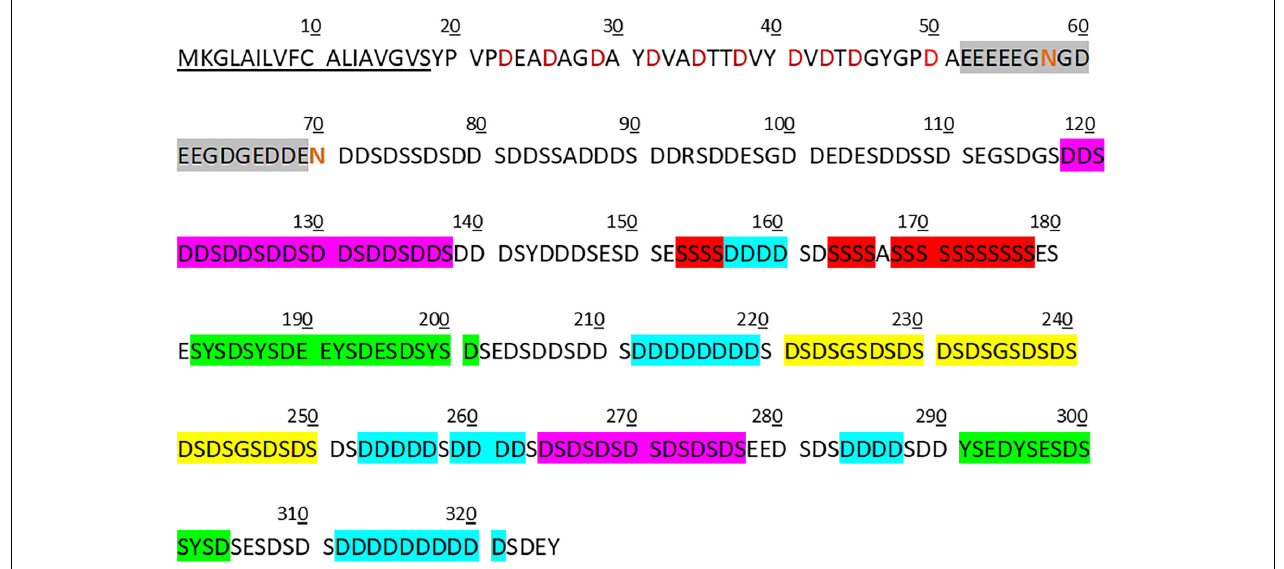
FIGURE 4 | Features of copy 1 of the folian-cv1 primary structure. The secreted protein can be divided approximately into three distinct regions following the signal peptide (underlined). The first is a relatively hydrophobic N-terminal region (33 residues in length) with regularly spaced asp residues (red symbols). This is in turn followed by a short glu-rich region (18 residues in length; gray box) which contains a 5-residue glu run and has the two asparagine residues in the protein (red symbols) in or immediately following the run. The remainder of the protein (255 residues) is generally asp-ser-rich. Notable sub-regions in the asp-ser-rich region include one that is exclusively DDS (7 tandem repeats in residues 118–138) and one that is exclusively DS (8 tandem repeats in residues 262–277) (pink boxes). In addition, there are three 10-residue tandem repeats for which each repeat has a single GS bracketed by two DS pairs (yellow box). Other repeat regions include poly-D runs (those runs greater than three shown in blue boxes), which are bracketed by S, poly-S runs (red boxes) and those that are Y-rich containing YS or SYSD sequences (green boxes). Nearly all of the ser, tyr, and thr were predicted to be possible phosphorylation sites using NetPhos 3.1 (www.cbs.dtu.dk/services/